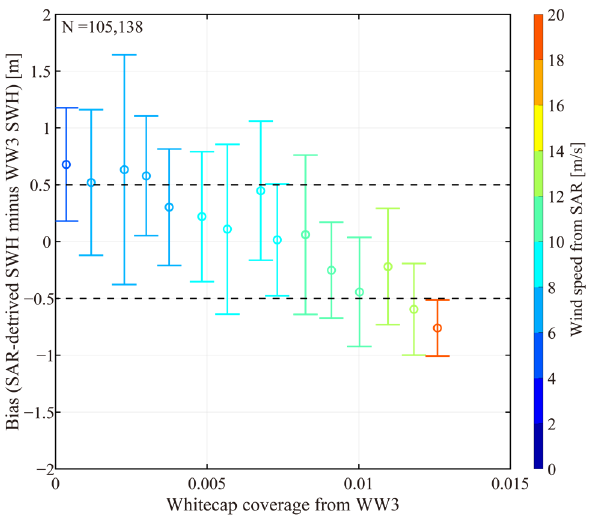
Figure 13. Validation of the SAR-derived SWH against the simulation results of the WW3 model in terms of the whitecap coverage from the WW3 model. The color bar denotes the SAR-derived wind speed.